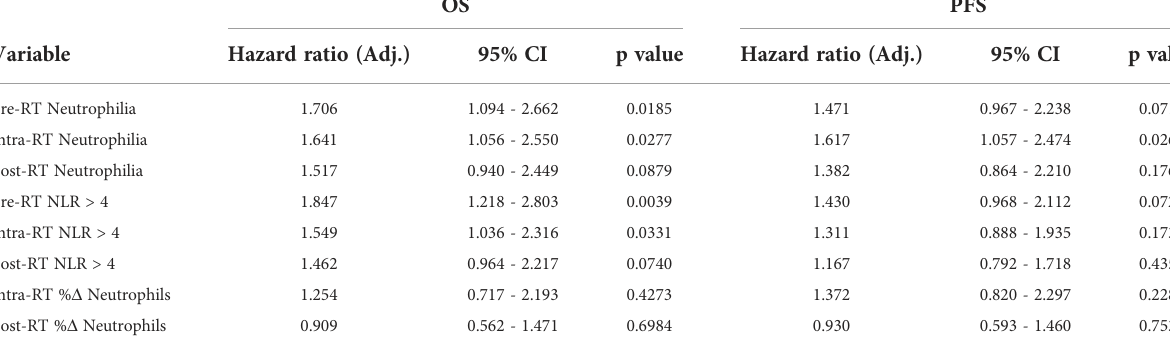
TABLE 2 Multivariable cox proportional hazards regression: Impact of neutrophils on OS and PFS. OS PFS Variable Hazard ratio (Adj.) 95% CI p value Hazard ratio (Adj.) 95% CI p